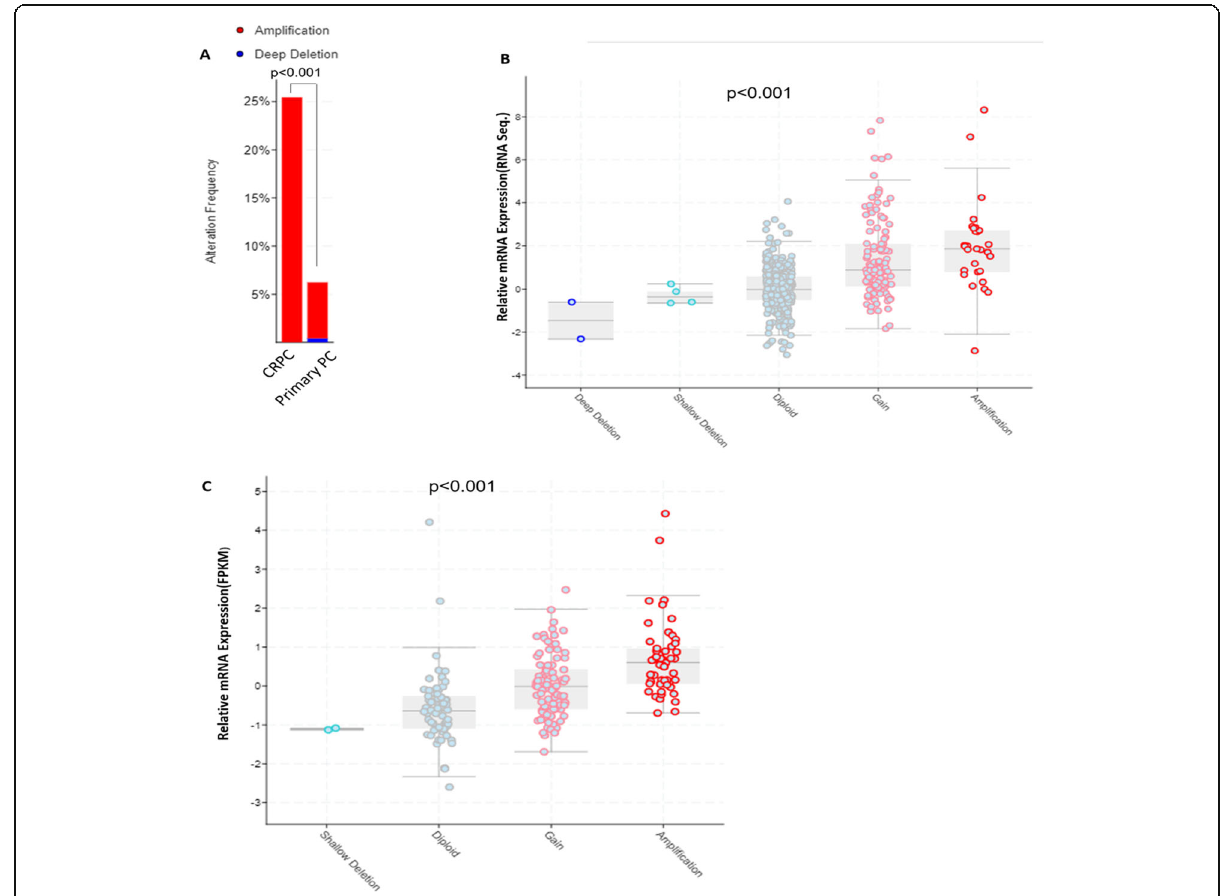
Fig. 1 Comparison of TERF1 in primary tumor and CRPC cohort. A Gene amplification in both primary and CRPC cohorts. B TERF1 gene expression in primary tumor. C TERF1 gene expression in CRPC due to gene